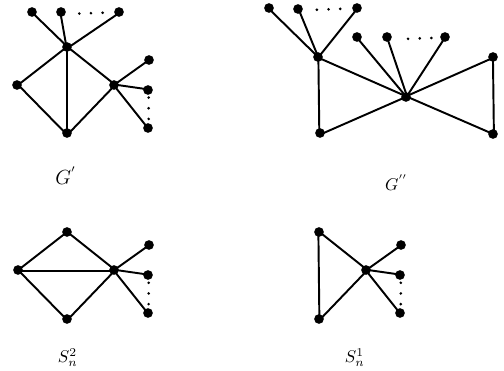
Figure 7. The graphs which are used in the later